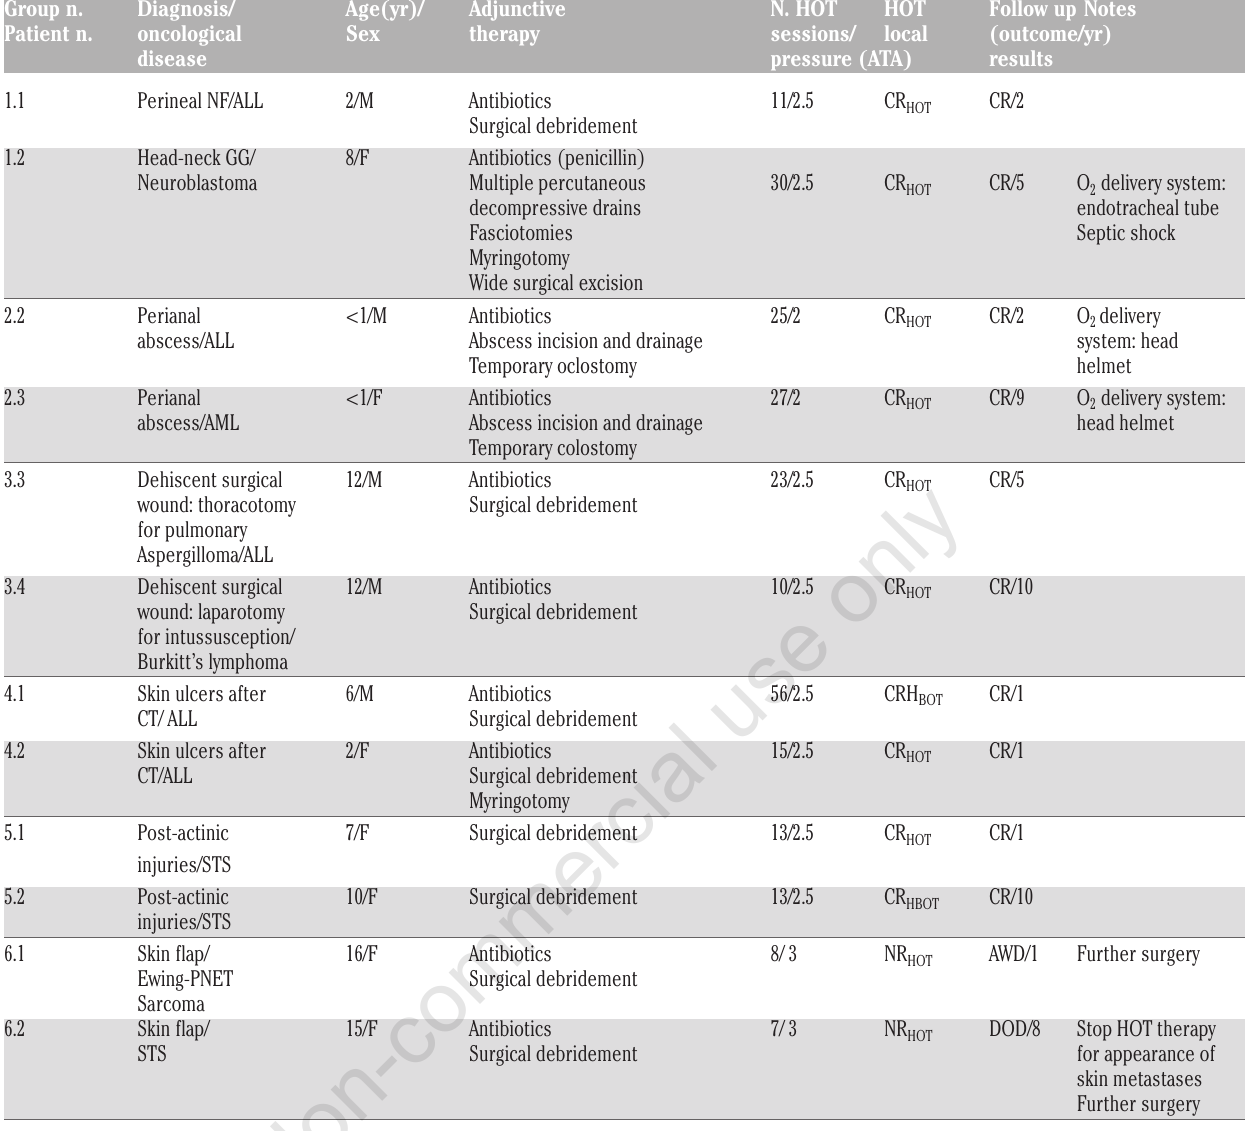
Table 1. Clinical features, schema and results of treatment. Group